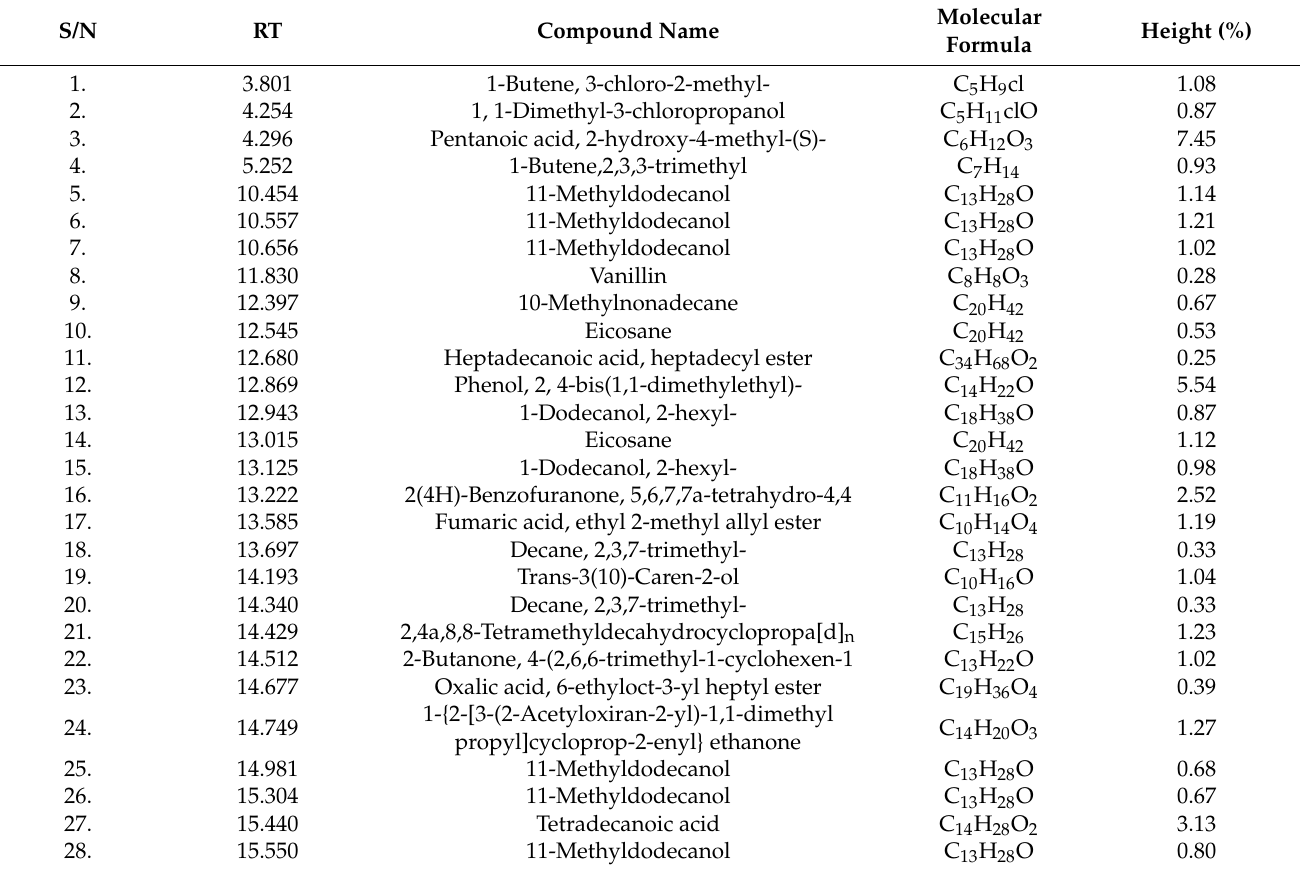
Compounds identified in the chloroform extracts of D. villosa leaves by GC–MS spectral